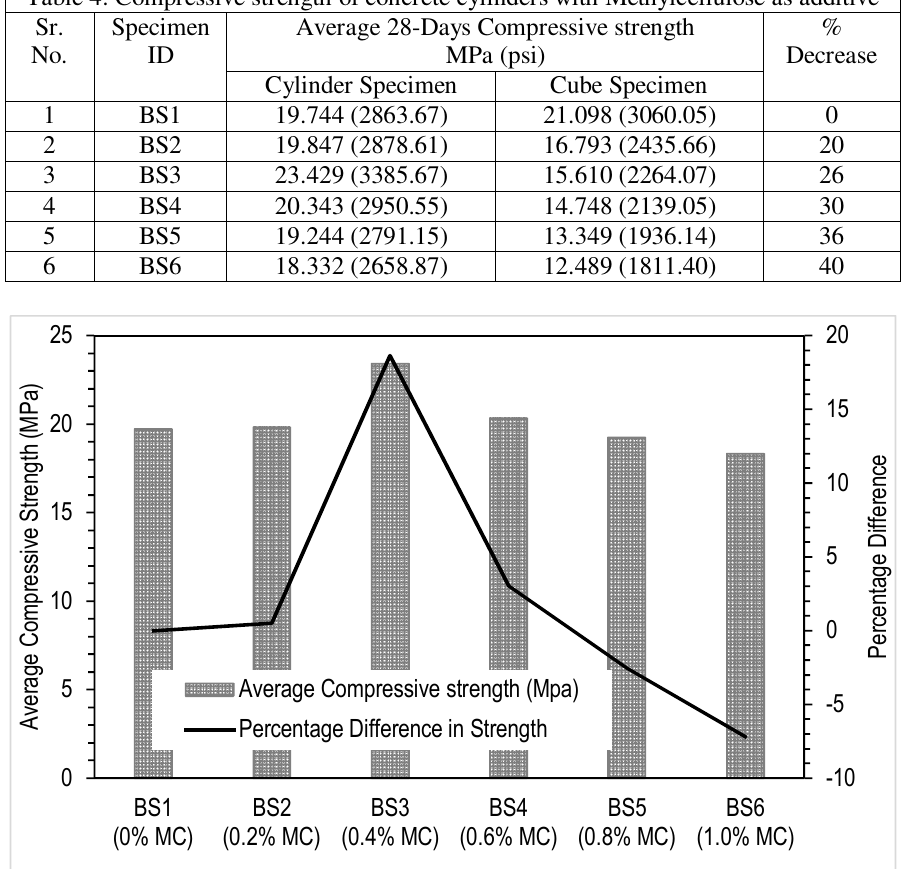
cylinder samples while Table 5 and Fig.7 present the results of concrete cube samples. Concrete cubes tests show that the presence of MC in concrete mix cause a reduction in cube compressive strength of concrete while the cylinder compressive strength shows a plateau effect. The reduction in concrete cube compressive strength goes parallel with the cement mortar cubes test results. Fig 5: SEM for Methyl Cellulose Ibrahim et al . [20]. Table 4: Compressive strength of concrete cylinders with Methylcellulose as additive Sr.